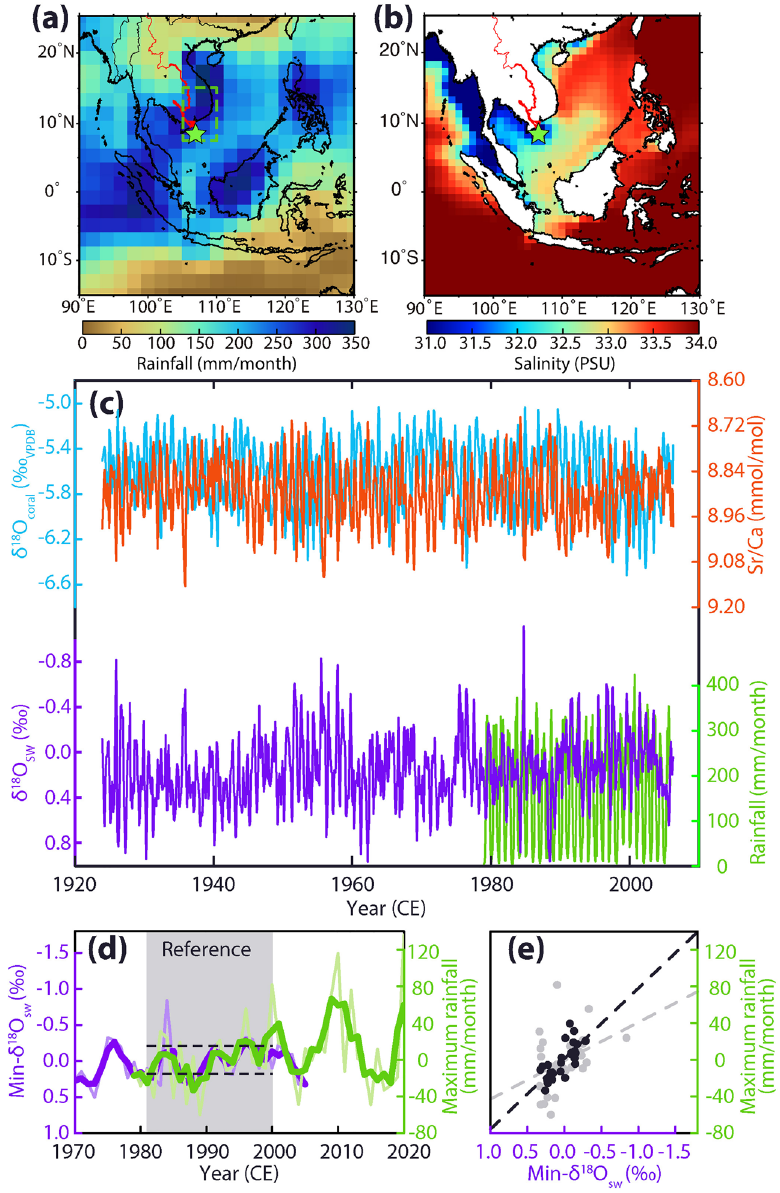
Figure 1. Calibration of coral-based records with meteorological data. ( a , b ) Rainfall (GPCP version 2.3) and salinity (EN4.2.1 45 ) in October from 1980 to 2005 CE. The star symbol indicates Con Dao Island. The red line shows the Mekong River. The map was generated by the GMT 4.5.12 46 . ( c ) Monthly resolution coral records of δ 18 O coral (blue), Sr/Ca ratio (red), and δ 18 O sw (purple) from December 1923 to June 2006 on Con Dao Island. GPCP version 2.3 rainfall from 1979 to 2020 (green) was derived from the southeastern part of the Indo-China Peninsula (7.5–15°N, 105–110°E, green box in panel a ). ( d ) Min-δ 18 O sw (purple) and maximum rainfall GPCP in the MRD (green). Thin and thick lines show the annual and 3-year moving averaged data, respectively. Grey shading and dashed lines indicate the reference interval (1981–2000 CE) and thresholds used to define heavy/ light rainy seasons. ( e ) A cross plot analysis between the min-δ 18 O sw and the maximum rainfall GPCP (grey: annual data; black: 3-year moving averaged data). Dashed lines indicate linear regression